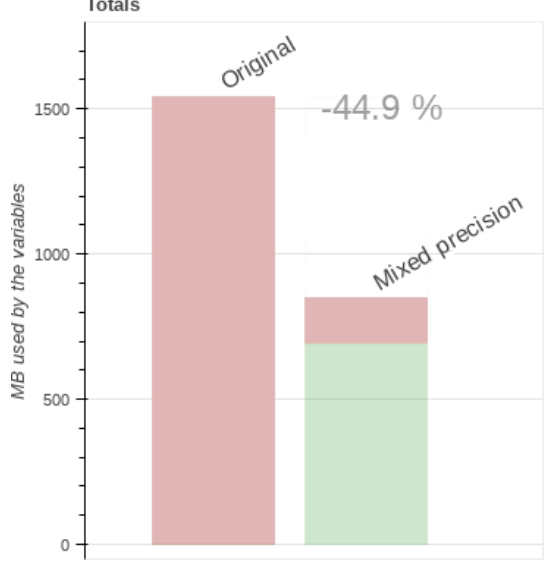
Figure 2. Estimation of the memory usage impact in an ORCA2 configuration using the set obtained with the loose accuracy test. The estimation has been performed using the dimensions of the variables and the size of the domain. In red (darker) we have the memory that is occupied by variables in double precision (100% in the original case), and in light green the proportion of the memory occupied by variables in single precision; the difference between the original case and the loose case implies a potential 44.9% decrease in memory